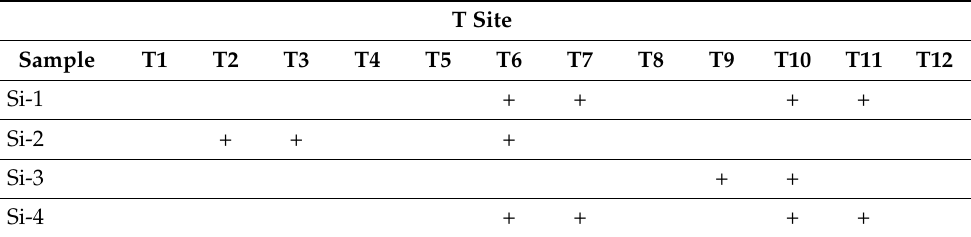
Table 1. Defects in tetrahedral sites (marked with a plus) of orthorhombic structures: